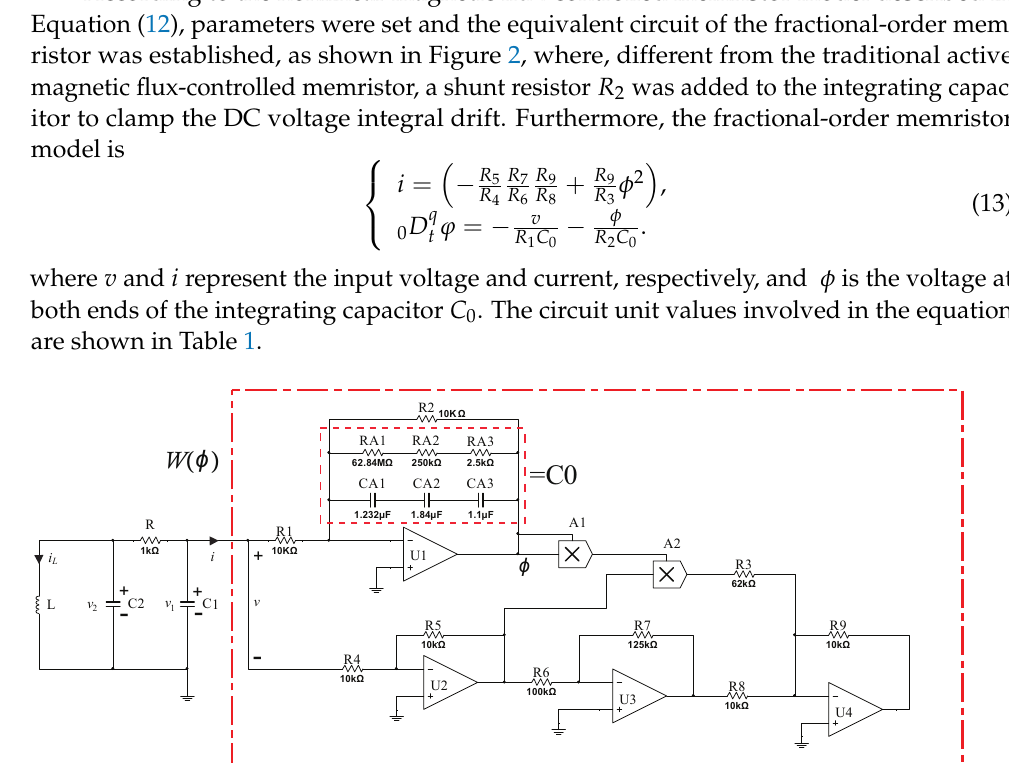
Table 1. Value of circuit elements of fractional-order memristor. Circuit